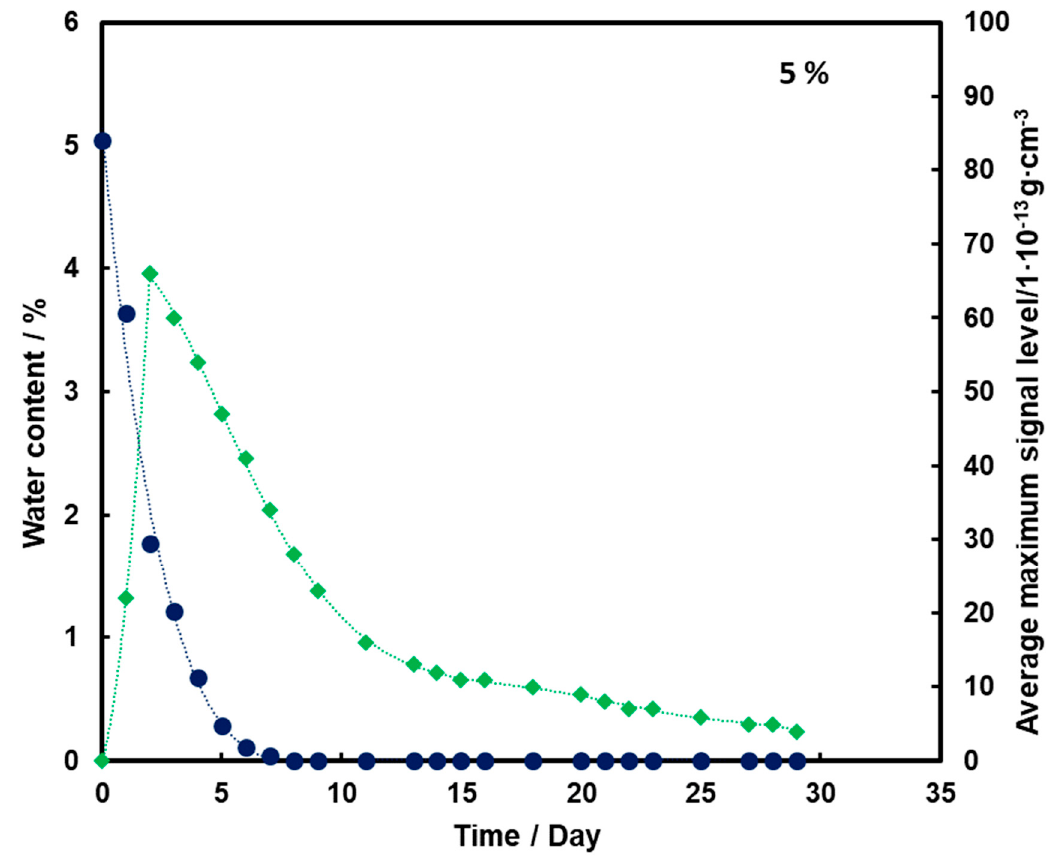
Figure 3. Dependence of the mean maximum TNT signal ( ♦ ) on the amount of water ( ● ) in time for a substrate with a moisture content of 5%.